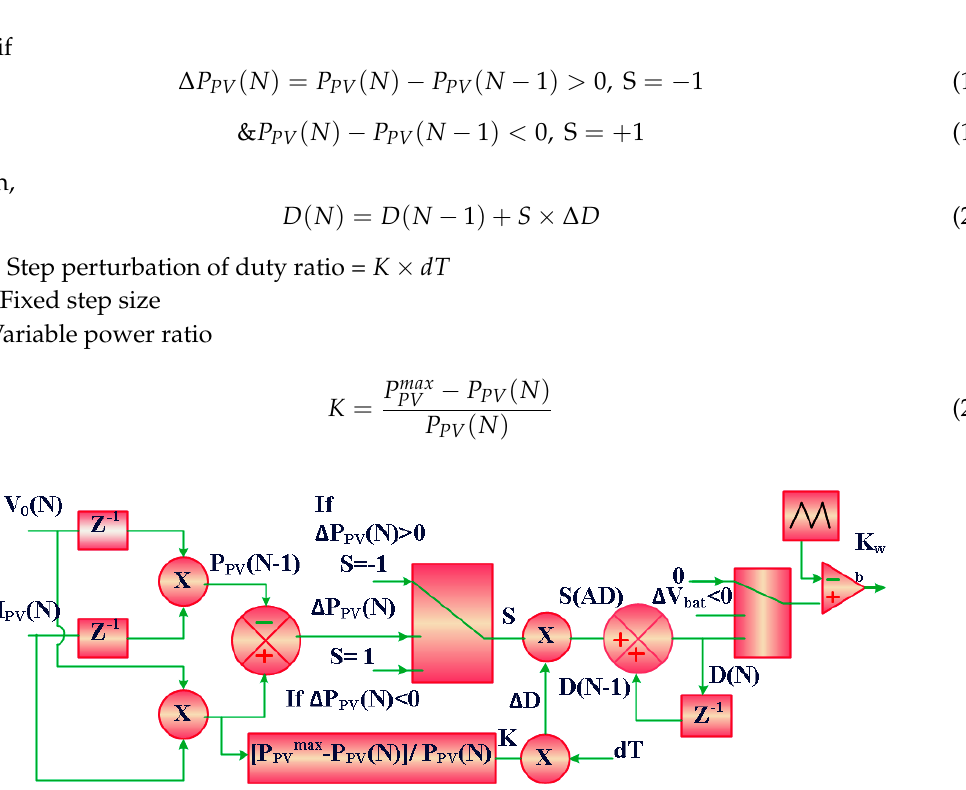
Figure 7. Equivalent power circuit of Quasi Z ‐ source inverter.